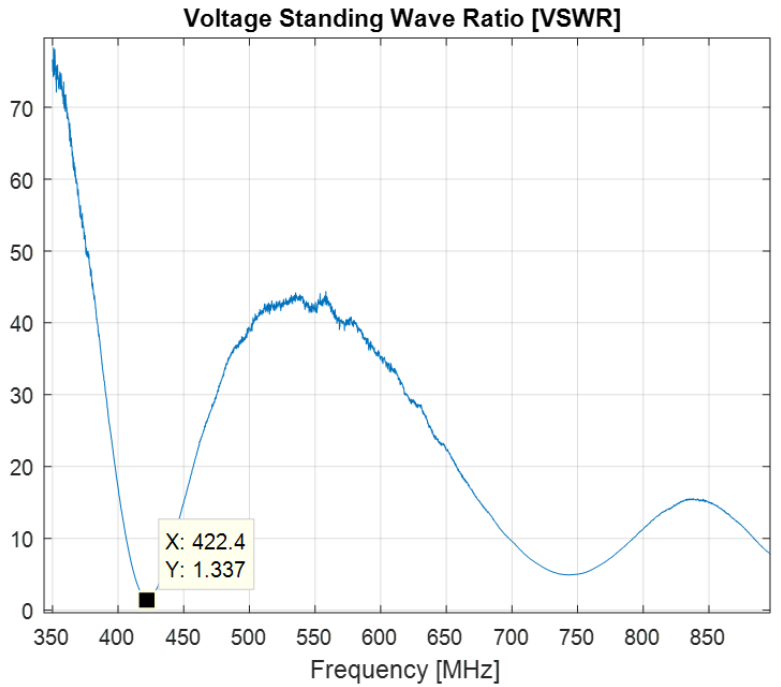
Figure 24. VSWR of the printed meander line monopole antenna with an input impedance matching circuit.